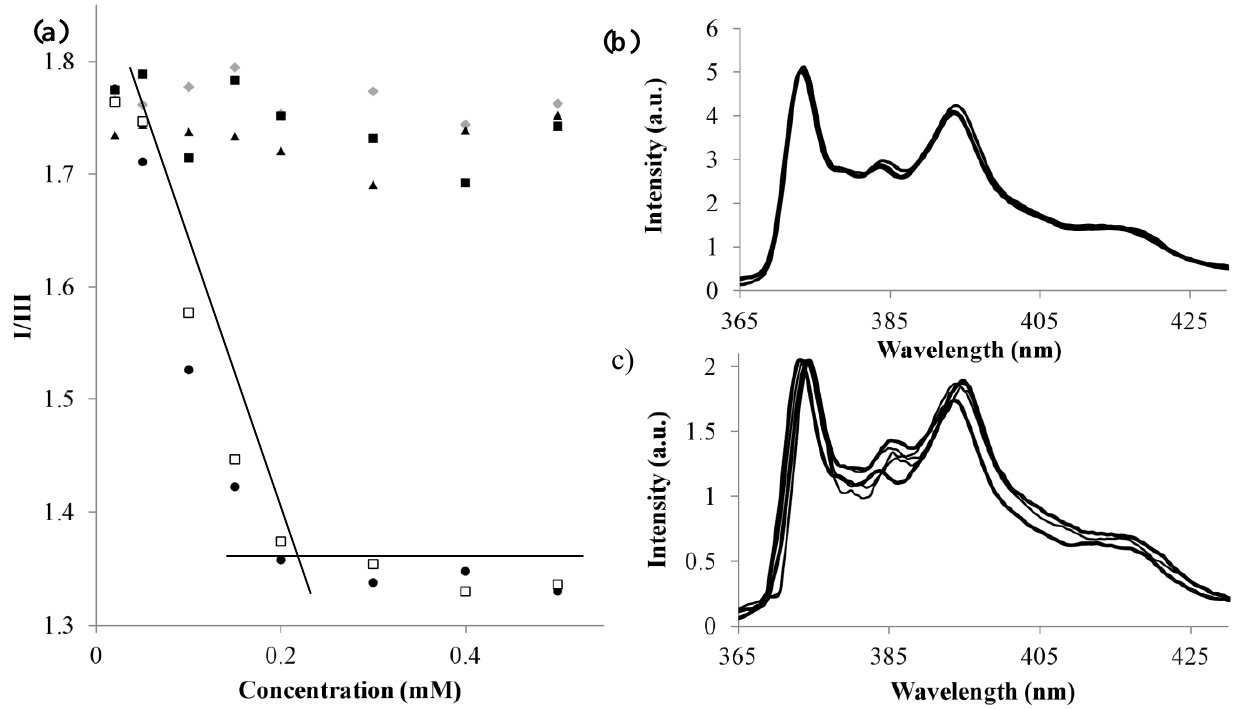
Figure 4. ( a ) Critical micelle concentration (CMC) of unfunctionalised polymer ( ■ ), 1 ( ■ ), 2 ( □ ), 3 ( ● ) and 4 ( ▲ ); Total volume of each sample 1.050 mL; ( b ) Example of pyrene spectra where no changes are observed upon increase of polymer concentration ( 4 );